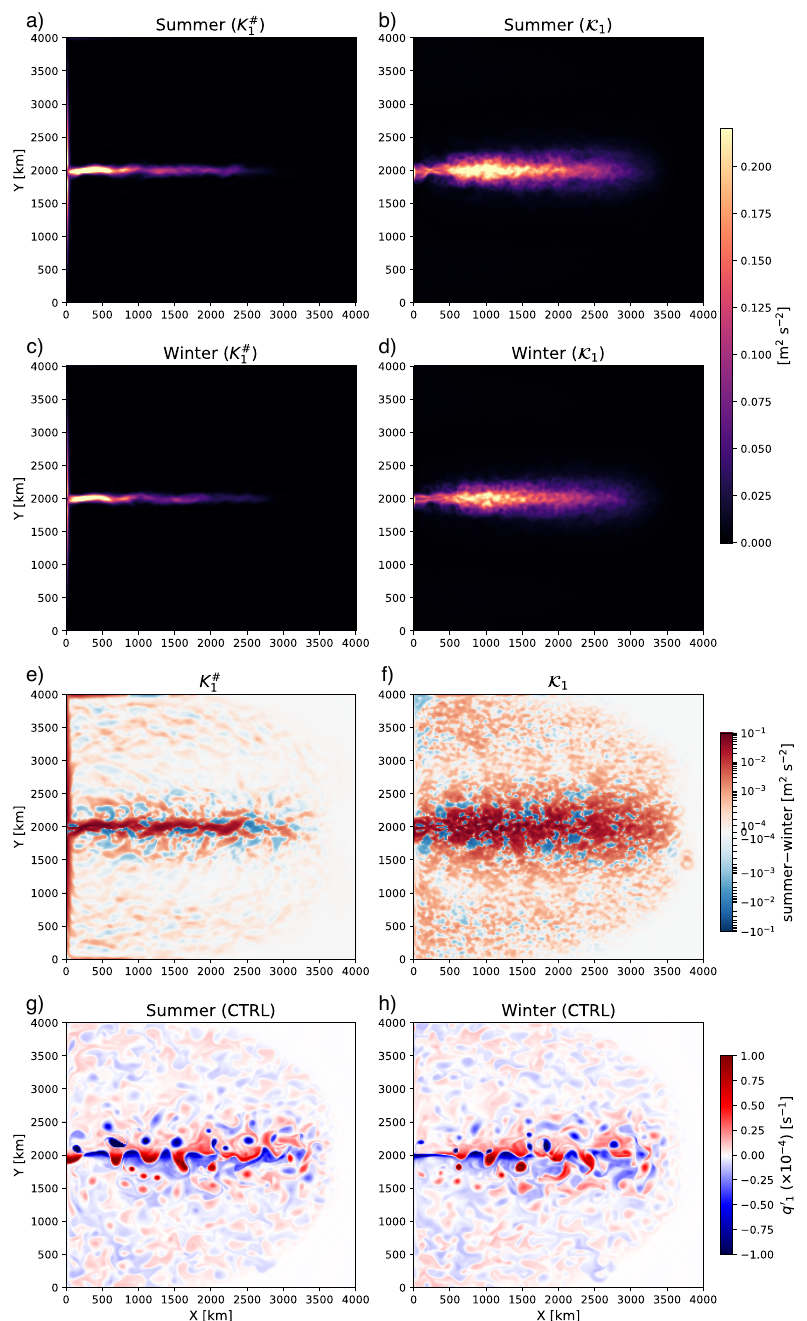
Figure 3. The summer and wintertime mean and eddy KE and their difference during the last year of output ( a – f ). Note the differences are plotted on a logarithmic scale. ( g , h ) Snapshot of eddy PV for summer and winter during the last year of output from the CTRL run. All panels show the variable in the first